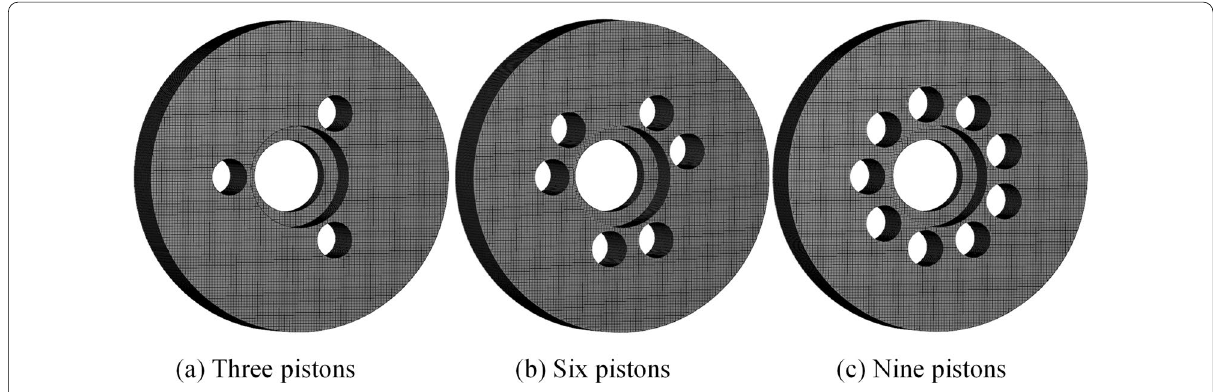
Figure 5 Grid of the fluid zone around the piston